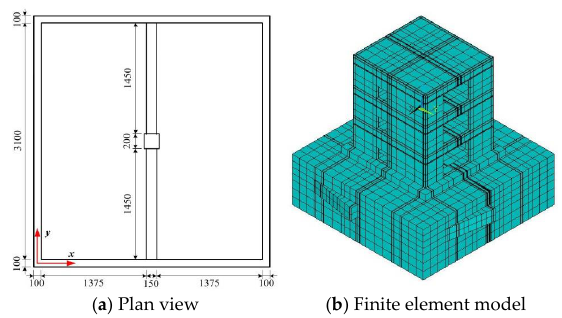
Figure 35. Finite element modeling of a hypothetical symmetric structure for comparison with the SMART 2013 RC structure.